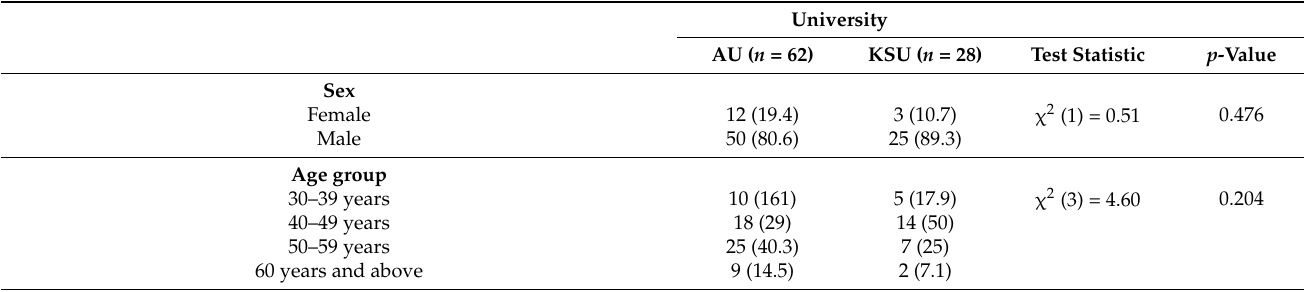
Table 8. Bivariate comparison of the teacher from the two universities on their perceived learning preferences and